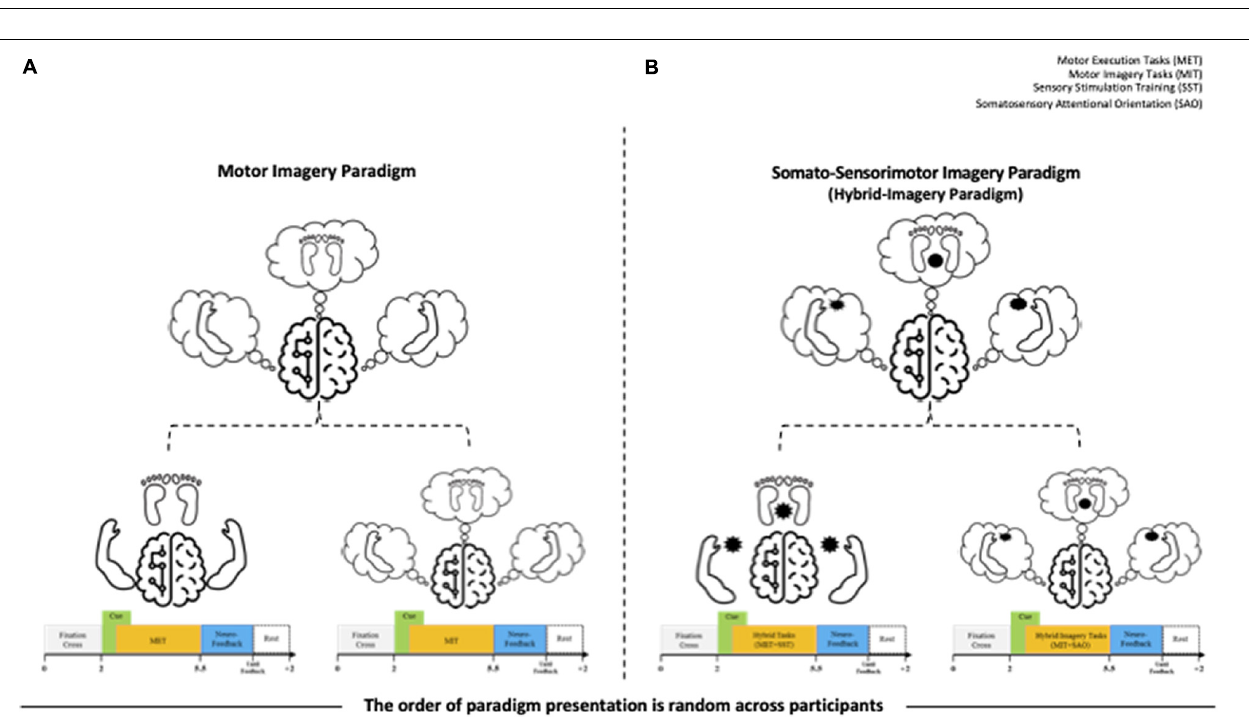
FIGURE 2 | Overview of the experiments for the motor imagery (MI) and somatosensory-motor imagery (SMI) paradigms. (A) MI paradigm. The left hand signals MET L and MIT L , the right hand signals MET R and MIT R , and the right foot signals MET F and MIT F . Subscripts: L, turn left; R, turn right; F, go forward. MET, motor execution task; MIT, motor imagery task. (B) SMI paradigm. The left hand signals SST-MET L and SAO-MIT L , the right hand signals SST-MET R and SAO-MIT R , and the right foot signals SST-MET F and SAO-MIT F . SST, sensory stimulation training; SAO, somatosensory attentional orientation.